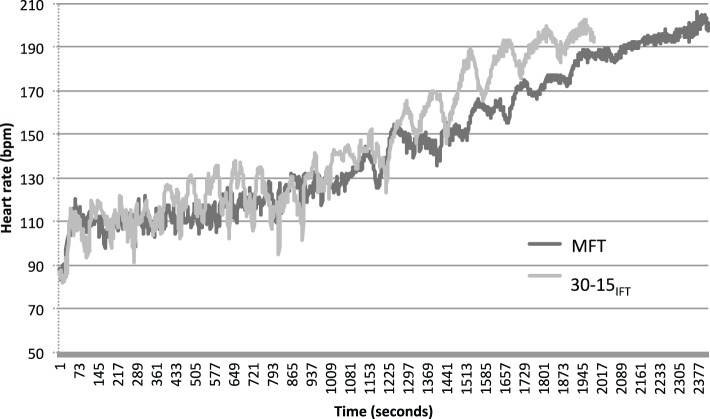
Example data illustrating heart responses during 30-15IFT and MFT for participant 12 (three point, IWBF classification).